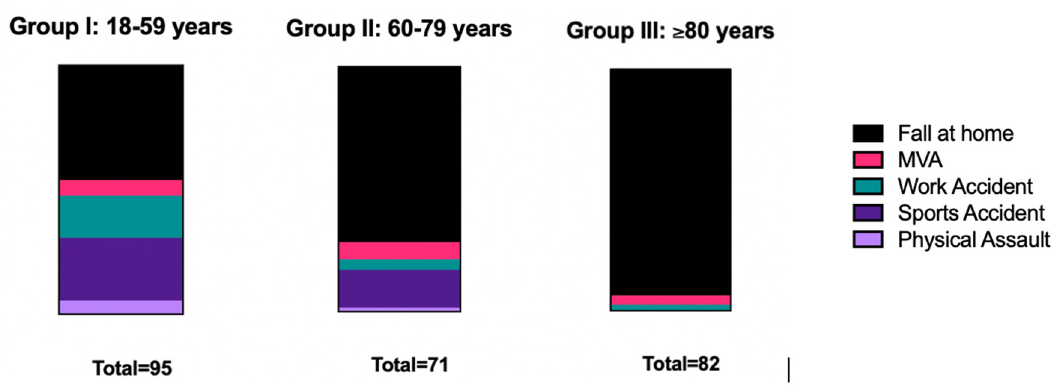
Figure 1. Association between age groups (I to III) and mechanism of injury. Associated injuries included clavicle bone fractures in three There were no missed PTXs on the initial CXR as evaluated by a radiologist and trauma surgeon.